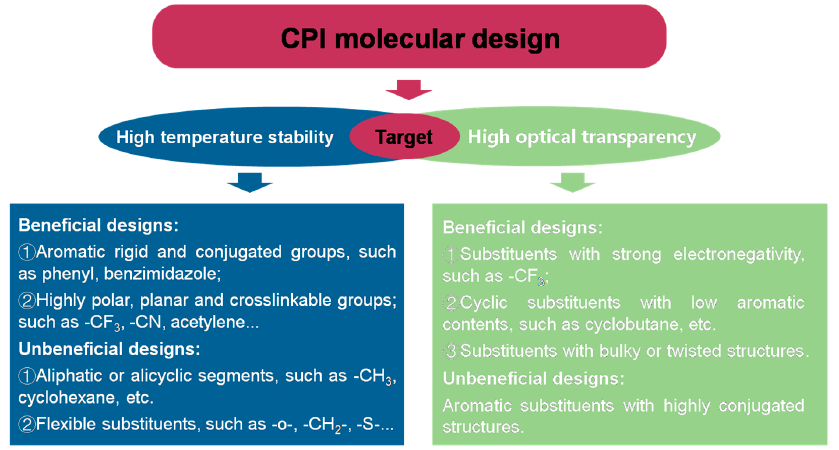
Figure 4. Schematic of CPI molecular design principles. Reprinted with permission from Ref. [61]. 2015,